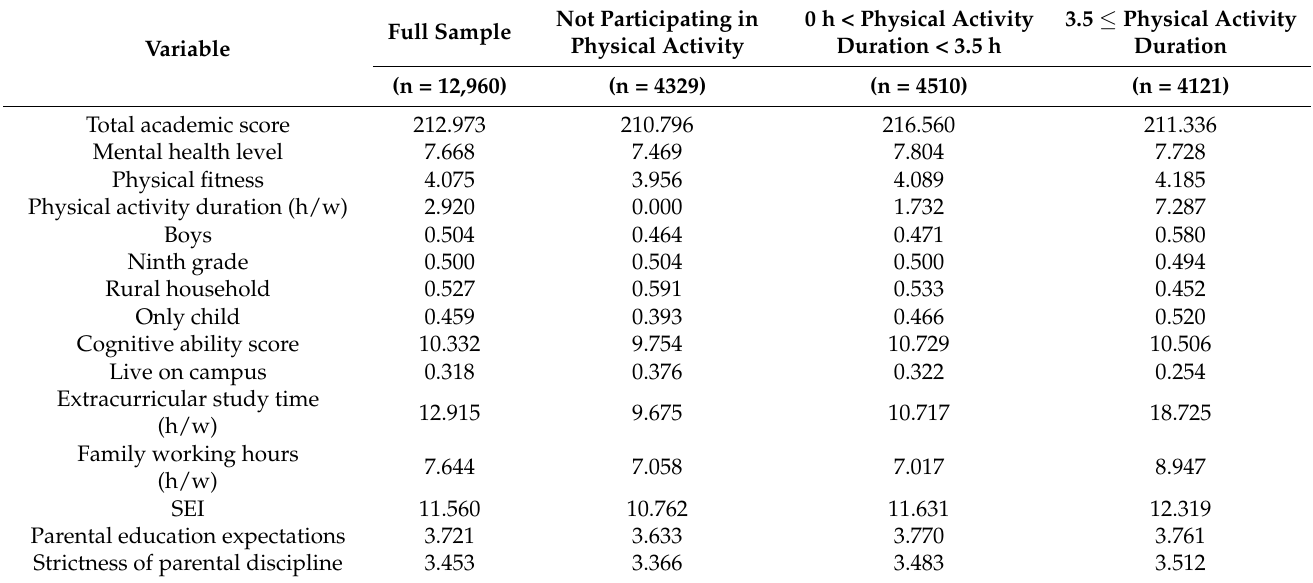
Table 1. Sample characteristics and differences in